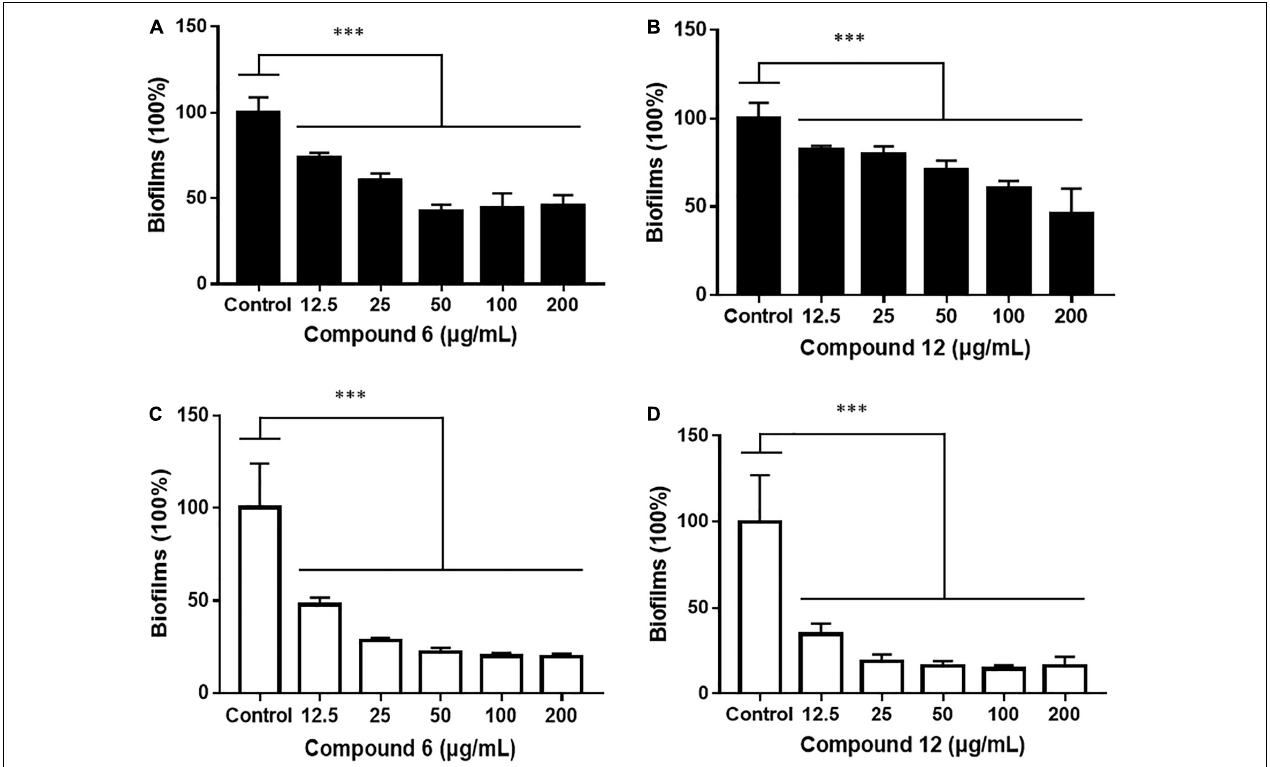
FIGURE 5 | Relative values of dose-response effects of compounds 6 and 12 against MRSA biofilms qualified by two different staining methods. The 24-h preformed biofilms were treated with different concentrations of compounds 6 (A,C) and 12 (B,D) using CV staining (A,B) and MTT staining (C,D) methods. The same volume of DMSO was used as negative control. Results are presented as percentages of the control. The data represent mean ± SD ( n = 9); ∗∗∗ p <